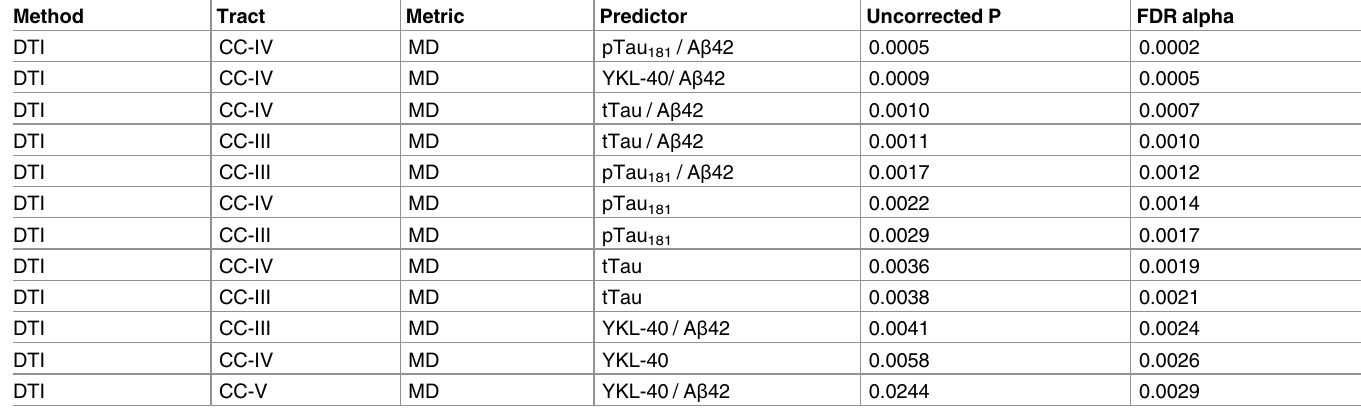
Table 4. DTI tractography results.